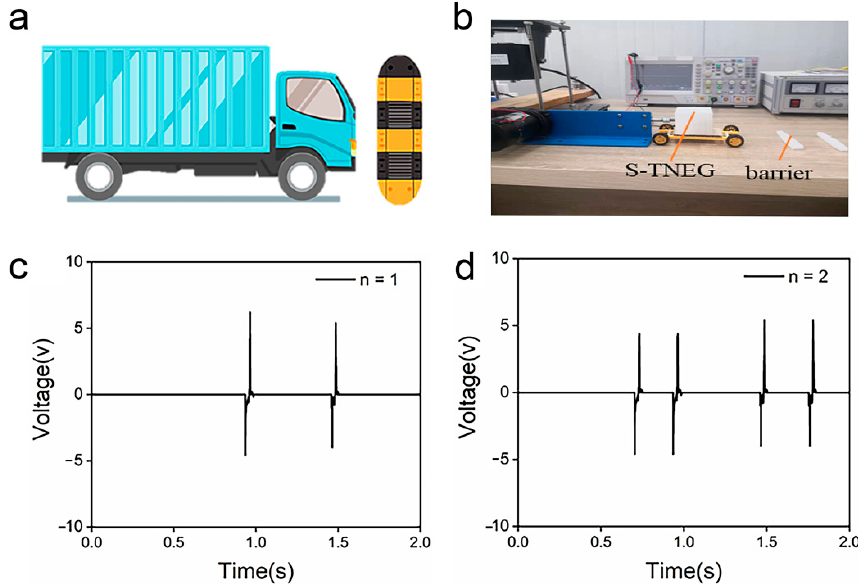
Figure 6. ( a ) Schematic diagram of the simulation platform. ( b ) Digital photographs of the simulation platform. ( c ) Test result when there was only a single speed bump. ( d ) Test result when there were two speed bumps.